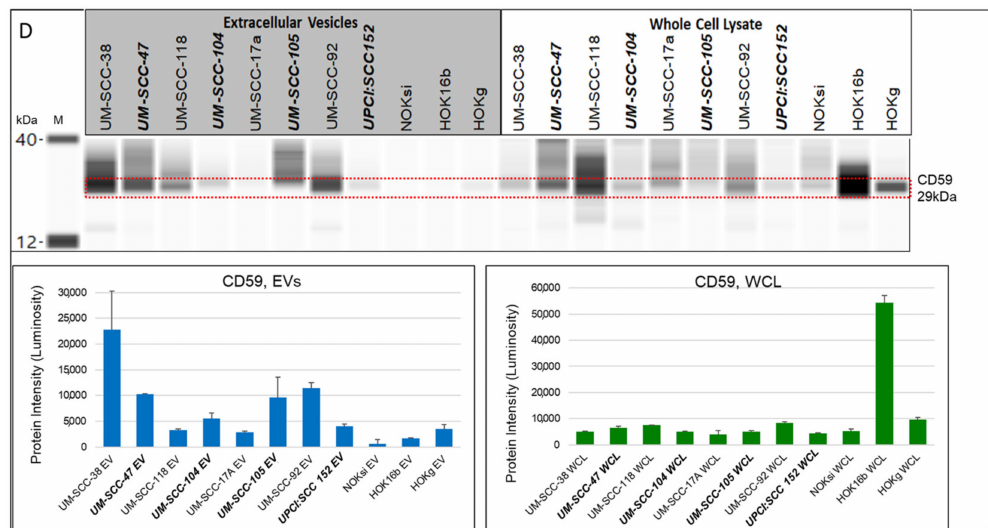
Figure 6. Wes protein gel and quantitative luminosity for extracellular vesicles and whole cell lysates from HNSCC, normal keratinocyte, and transformed cell lines. ( A ) STAT3 detected at 86 kDa, 1:25 antibody dilution, 0.5 µ g/ µ L protein; ( B ) β Catenin detected at 92 kDa, 1:200 antibody dilution, 0.25 µ g/ µ L protein; ( C ) EPHA2 detected at 100 kDa,1:100 antibody dilution, 0.5 mg/mL protein; and ( D ) CD59 detected at 29 kDa,1:100 antibody dilution, 1:7, 1 mg/mL protein. Bold italics: